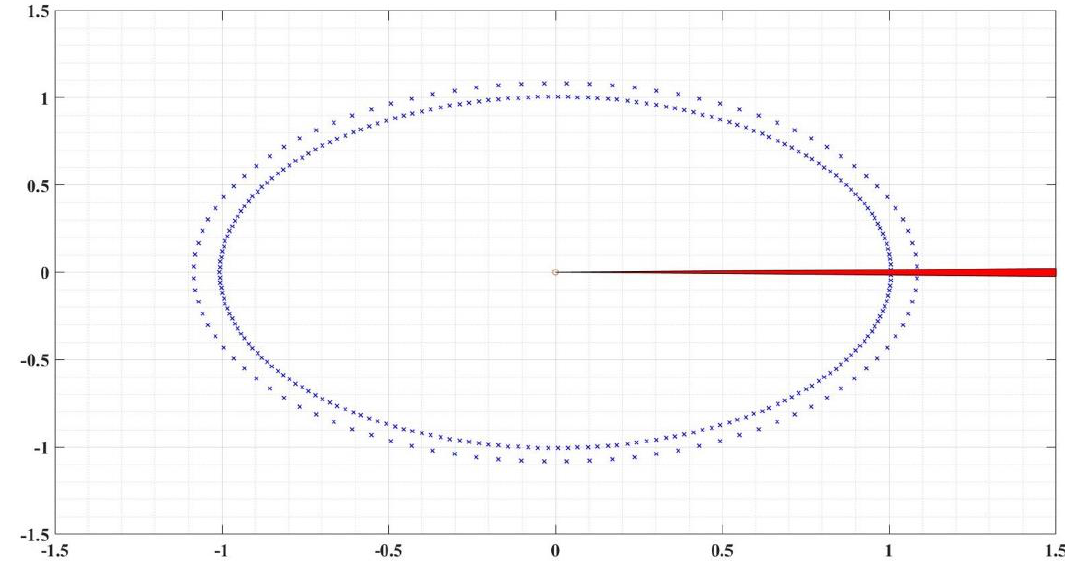
Figure 6. Stability test for the closed-loop control system for the power electronic converter using an FO lead-lag controller.